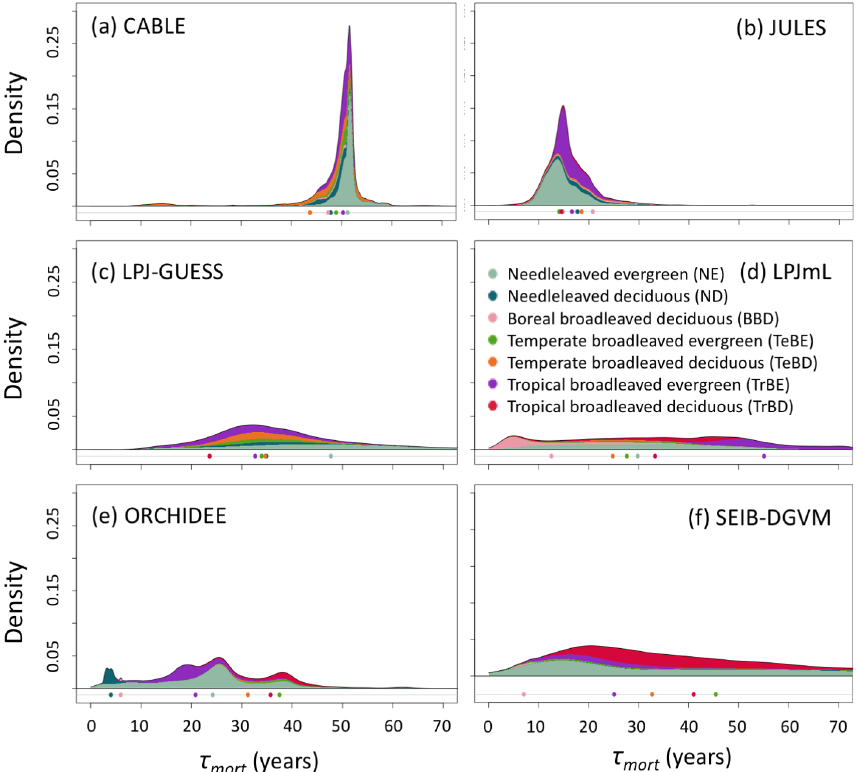
Figure 5. As for Fig. 2 but for turnover times due to mortality alone, τ mort ( C veg /F mort ). τ mort was derived from entire grid cell C veg and F mort (see Sect. 2.4), and grid cells were classified according to dominant PFT. Circles underneath distributions show the mean turnover time for each forest